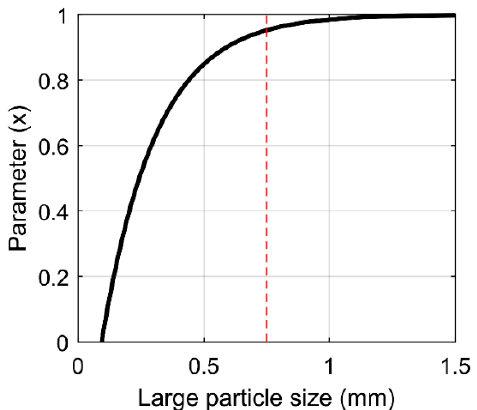
Figure 5. Parameter x as function of large particle size d l as described by Equation (6) for d cri = 0.15, while 𝑑 (cid:3039) = 0.75 mm is highlighted by dashed vertical red line, for which x = 0.95.